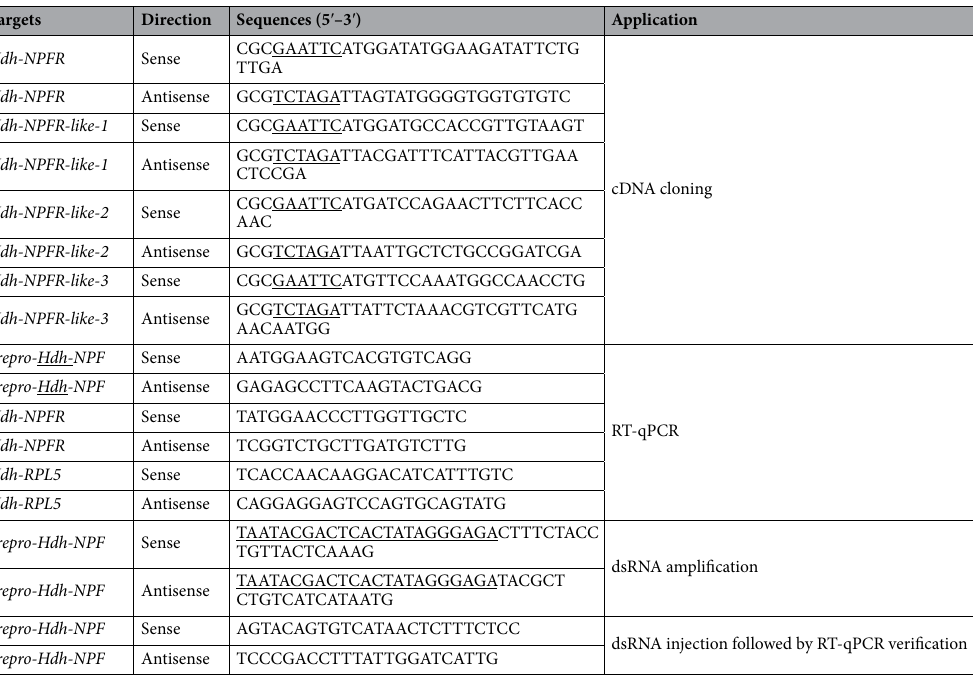
Table 2. Oligo primer sequences used in the polymerase chain reaction. Underlines and double-underlines indicate restriction enzyme recognition sites and T7 promoter sequence,